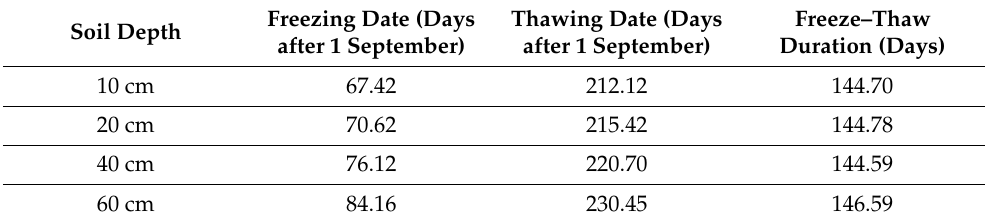
Table 1. Multi-year means of soil freeze–thaw processes at different soil depths.